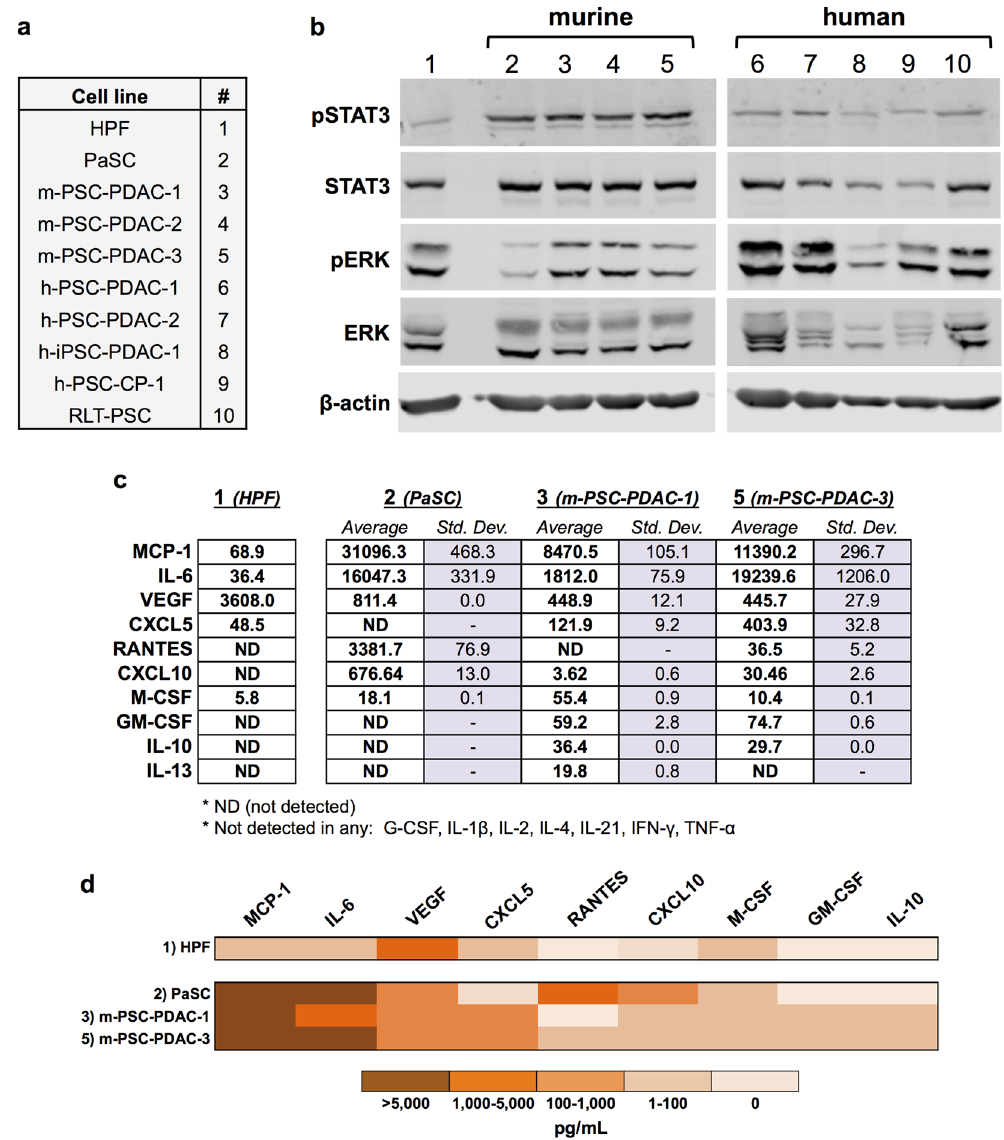
Figure 2. PSC display constitutive activation of STAT3 and MAPK signaling and secrete pro-inflammatory factors. ( a ) Summary of all PSC and PSC cell cultures used. (b) Cells were grown in DMEM and lysed once they reached 70–80% confluence for western blot analysis. pSTAT3, STAT3, pERK, and ERK were analyzed by immunoblot. β -actin served as a loading control. (c) Supernatants from 3 murine PSC cell lines and the human control pancreas-derived fibroblast line (HFP) (detailed in Table 1) were collected from 70% confluent cells grown in DMEM. A panel of cytokines and chemokines was analyzed in these supernatants by Luminex assay. Values are listed as an average of two replicates in pg/mL with the standard deviation. ND indicates analytes were assayed, but the levels were detected beneath the lowest standard curve reference value. (d) Selected results from the Luminex assay, presented as a heat